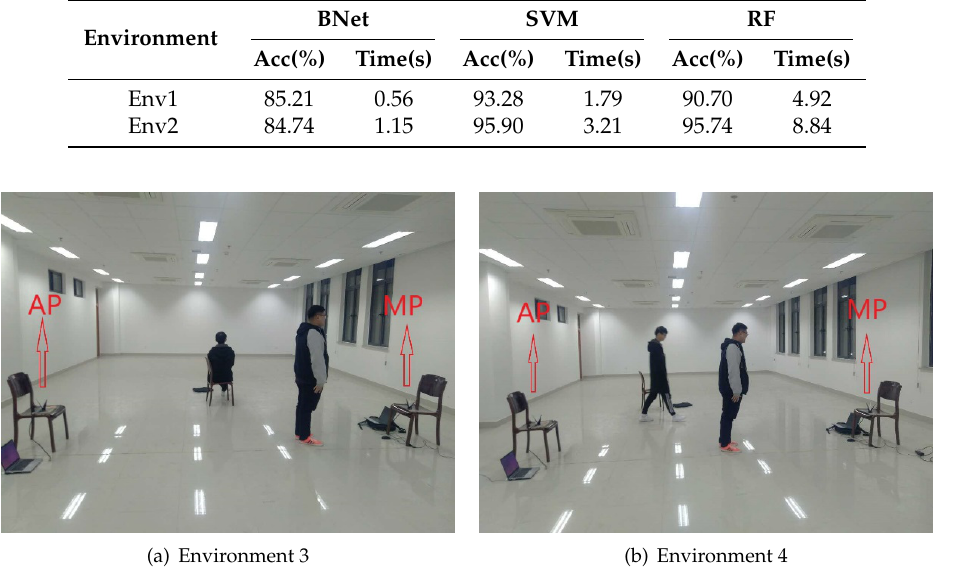
Figure 12. The impact of human interferences.